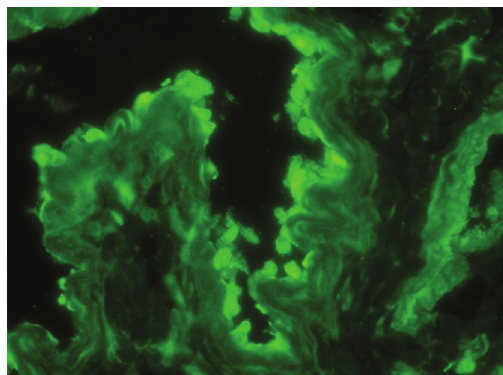
Figure 7: Indirect immunofluorescence was positive using rat bladder epithelium as a